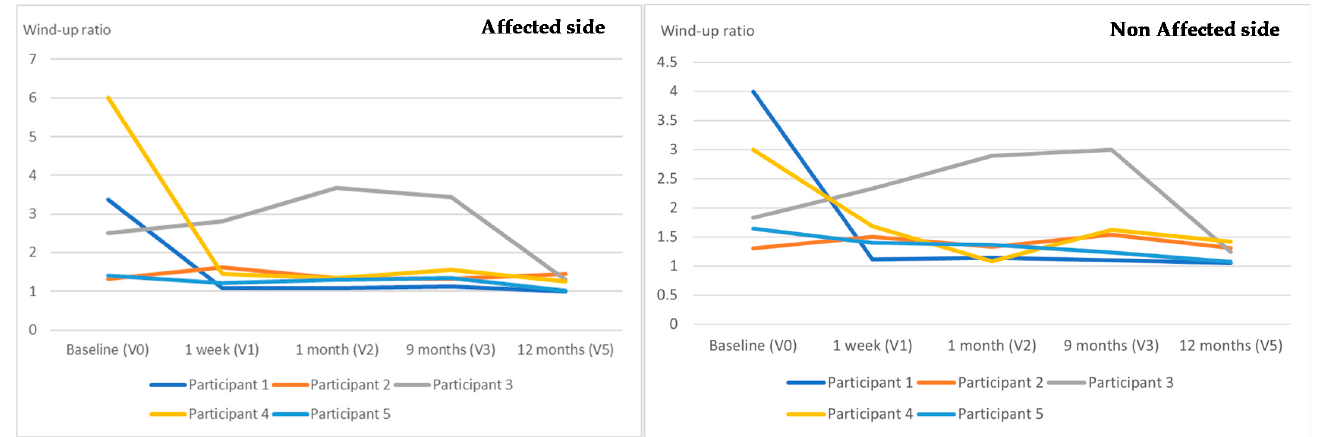
Figure 3. Evolution of the temporal summation throughout the study.